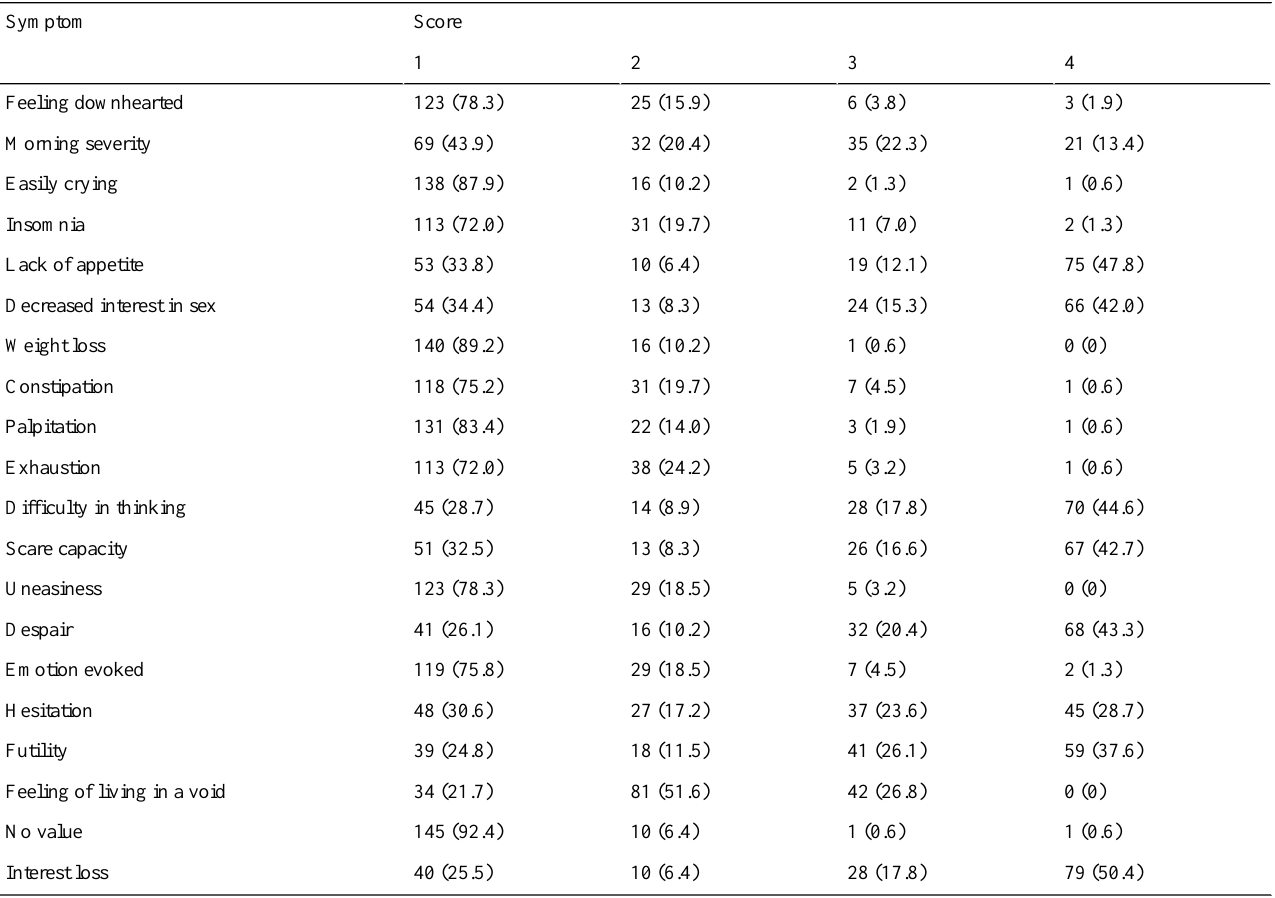
Table 3. The distribution of the Self-Rating Depression Scale scores of the surveyed medical students